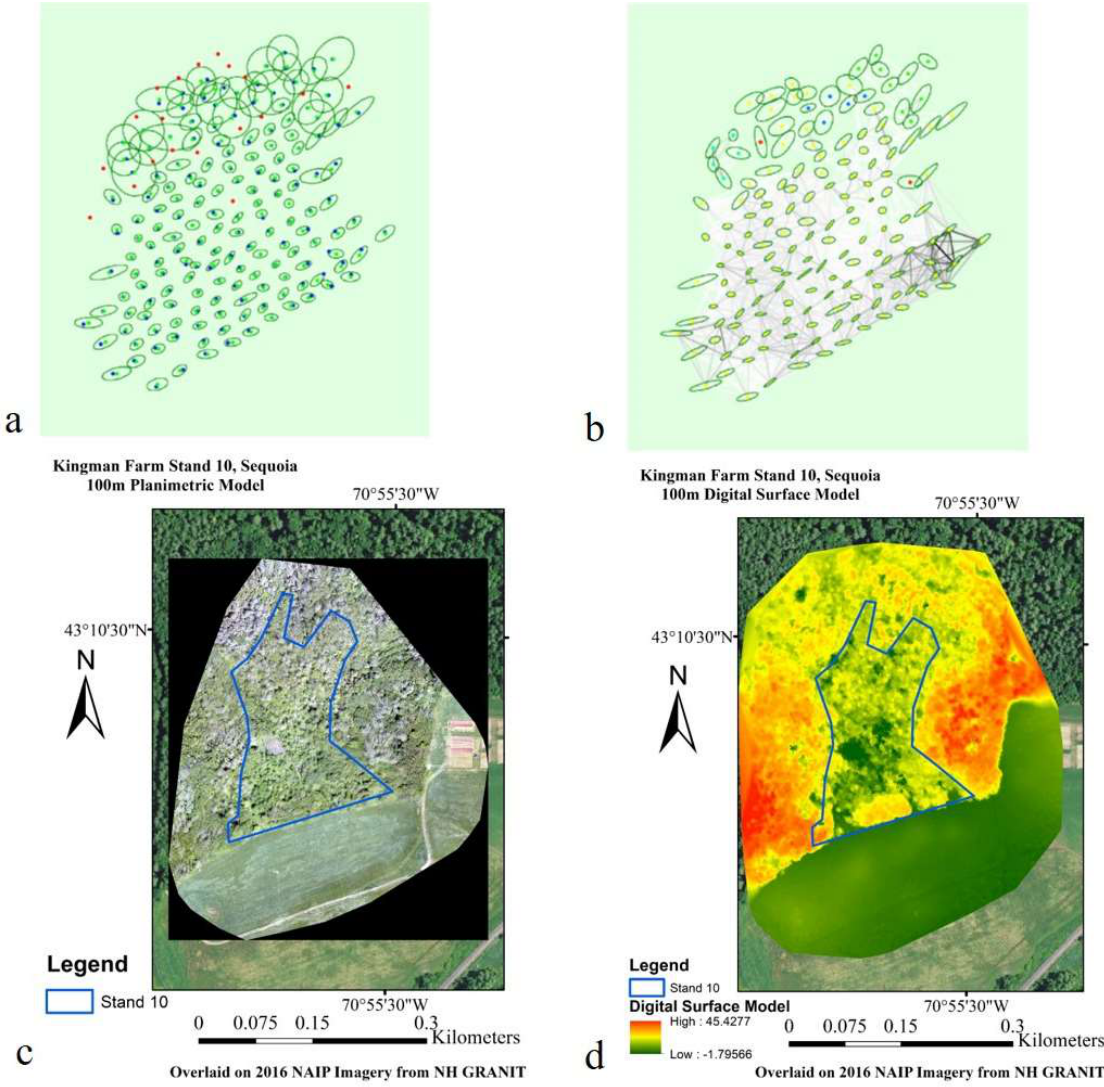
Figure 6. Pix4D mapper Pro initial processing results for the Sequoia RGB sensor at a 100-m flying height above the canopy height model: ( a ) image alignment success (green), failure (red), and additional uncertainty in location for images (green lines to blue location); ( b ) image-matching strength (weight of line network), and tie point geolocation precision (circle area); ( c ) final orthomosaic product; and ( d ) DSM.